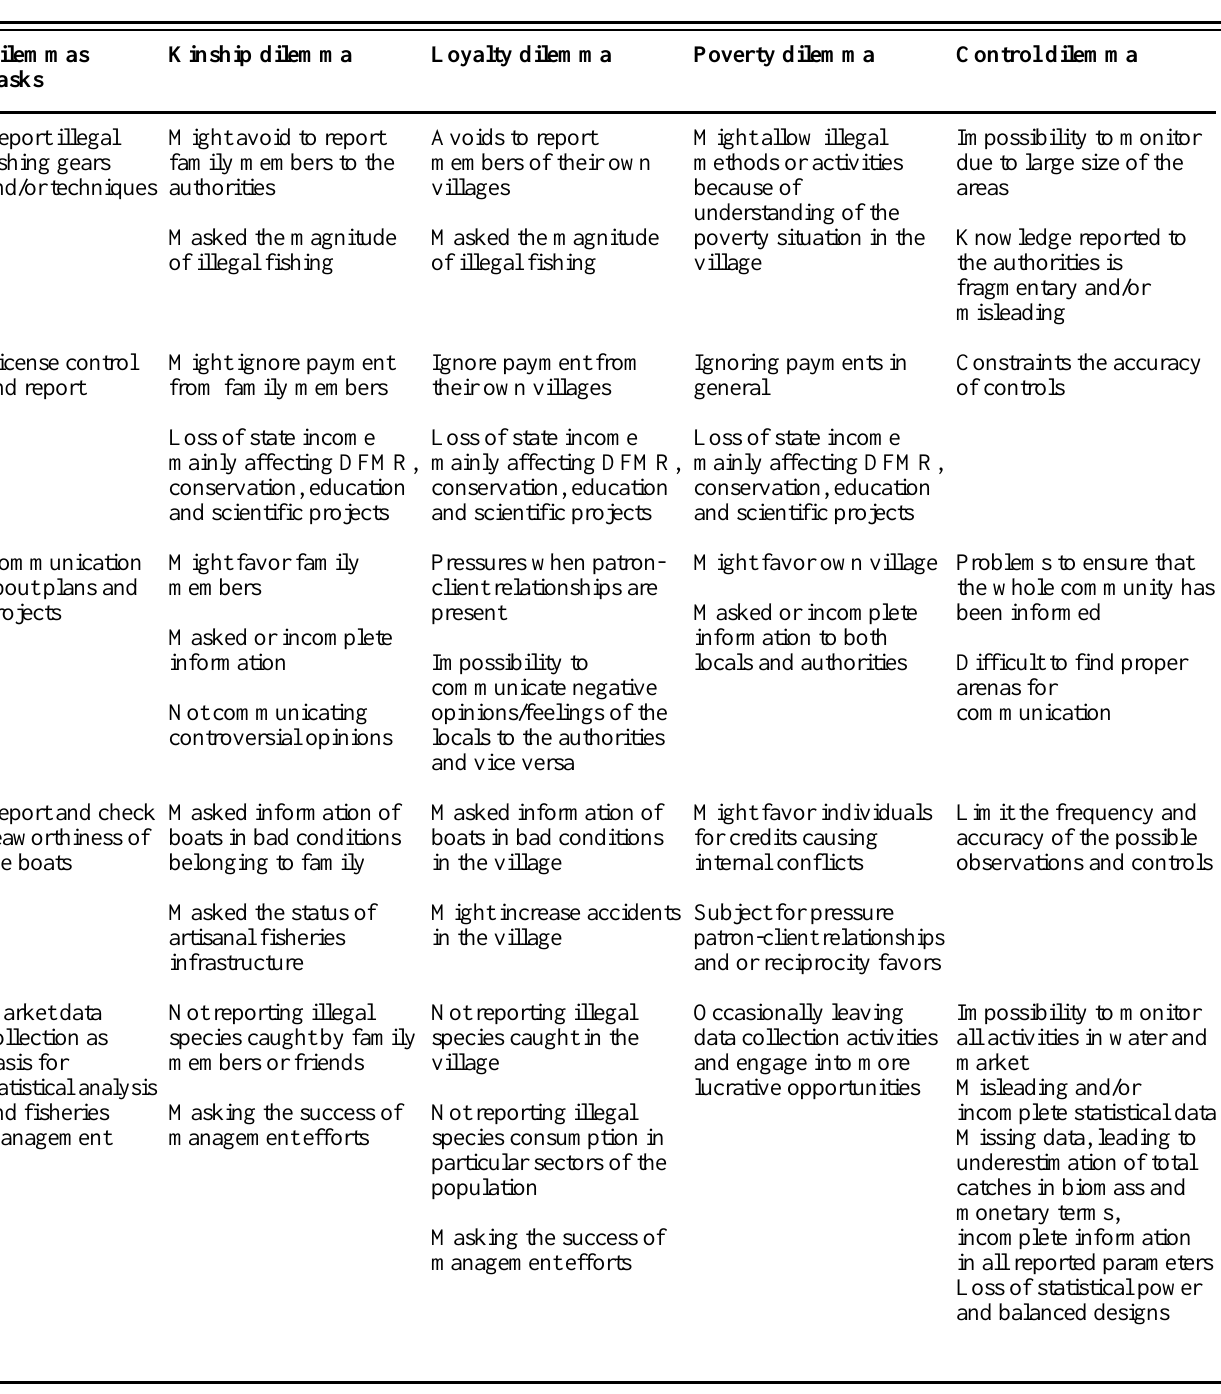
Table 1. Examples of interactions between the dilemmas and selected monitoring tasks of the Bwana Dikos. Kinship in this context extends to all members of the extended family and includes also multiple marriage and secret